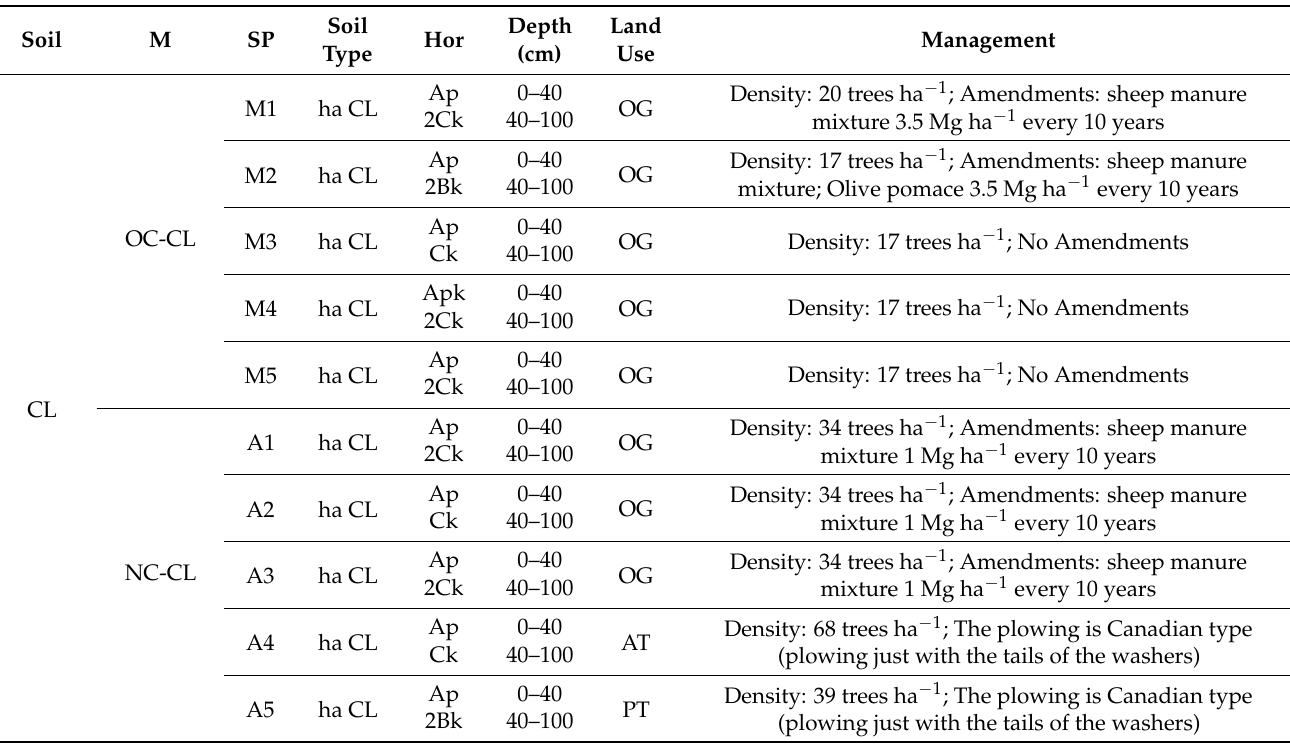
Table 3. Land use, managements, and soil qualifiers of the soils (Calcisols) in the study